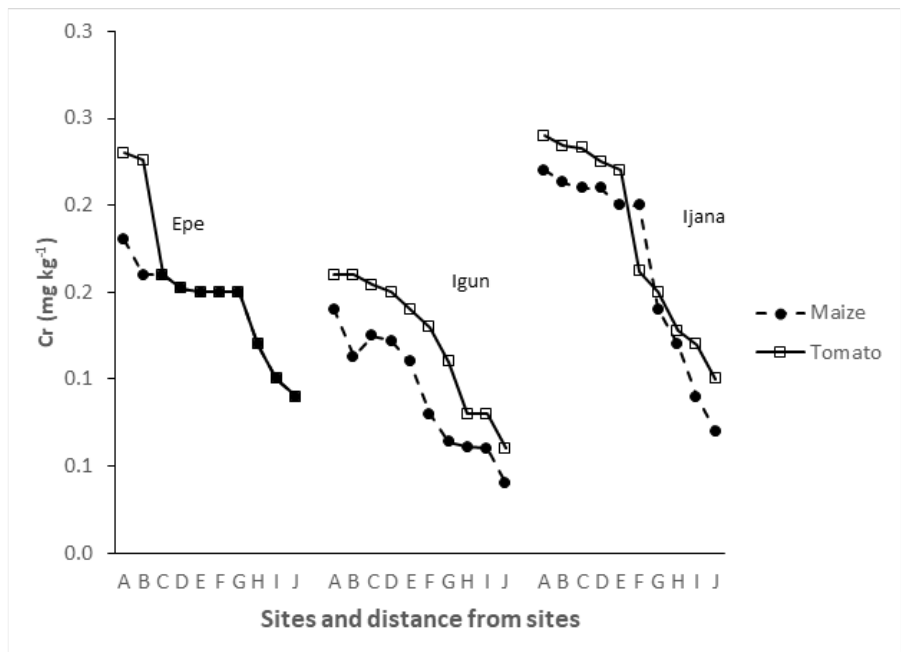
Figure 9: Concentrations of Cr in maize and tomato crops at Epe, Igun & Ijana (0 – 900 m) sites. A = 0 m from site; B = 100 m from site; C = 200 m from site; D = 300 m from site; E = 400 m from site; F = 500 m from site; G = 600 m from site; H = 700 m from site; I = 800 m from site; J = 900 m from